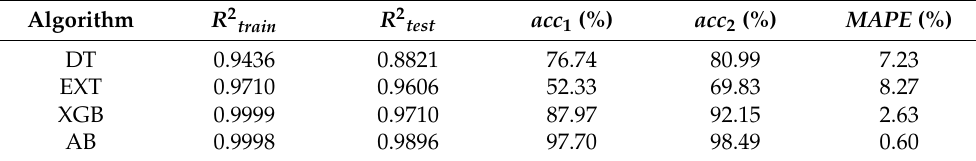
Table 5. Machine-learning